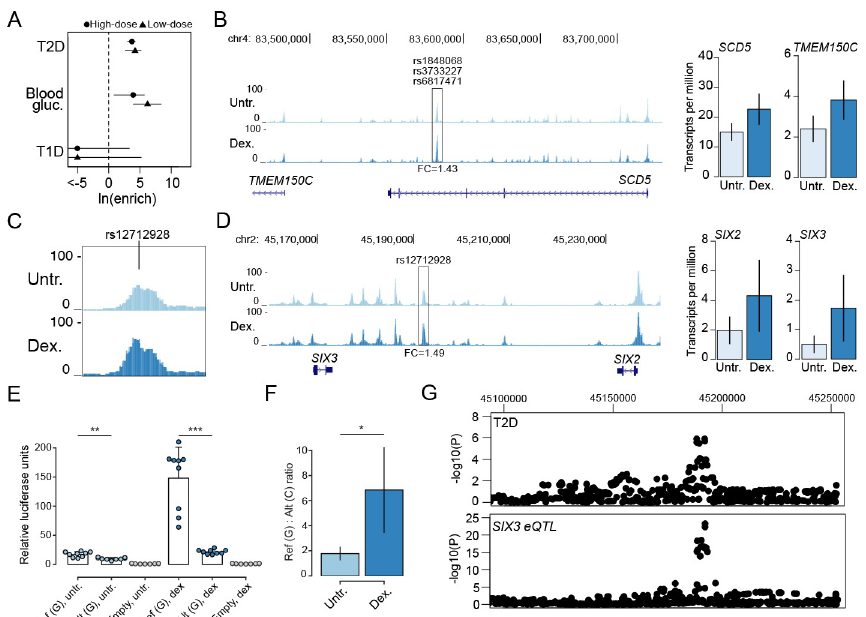
Fig 4. Type 2 diabetes and glucose associated variants affect glucocorticoid-responsive islet regulatory programs. (A) Enrichment of variants associated with type 1 diabetes (T1D), type 2 diabetes (T2D) and blood sugar (glucose) levels for differential chromatin sites in high-dose and low-dose glucocorticoid-treated islets. Values represent log enrichment estimates and 95% confidence intervals. (B) Multiple fine-mapped T2D variants at the SCD5/TMEM150C locus mapped in a glucocorticoid-responsive islet accessible chromatin site. Both the SCD5 and TMEM150C genes had increased expression in glucocorticoid-treated islets. Genome browser tracks represent RPKM normalized ATAC-seq signal, and bar plots represent mean expression and standard error. (C, D) Variant rs12712928 with evidence for blood sugar and T2D association mapped in a glucocorticoid-responsive chromatin site at the SIX2/3 locus. Both the SIX2 and SIX3 genes had increased expression in glucocorticoid-treated islets. Genome browser tracks represent RPKM normalized ATAC-seq signal, and bar plots represent mean expression and standard error. (E) Variant rs12712928 had significant allelic effects on enhancer activity in gene reporter assays in MIN6 cells. Values represent mean and standard deviation. (F) The allelic effects of rs12712928 were more pronounced in glucocorticoid-treated relative to untreated islets. Values represent fold-change and 95% CI. (G) The T2D association signal at SIX2/3 was colocalized with an eQTL for SIX3 expression in islets. For panels B, C and D the values shown are from results using high-dose treatment. For panels B and D, the fold-change (FC) in accessible chromatin signal in glucocorticoid treatment compared to untreated is indicated at highlighted sites. ��� P < 1x10 -4 , �� P < 1x10 -3 , � P < 1x10 -2